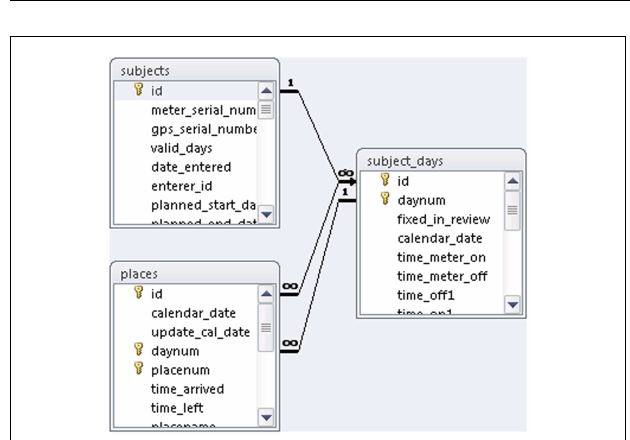
FIGURE 1 | Paper travel diary for two places in a single travel day .